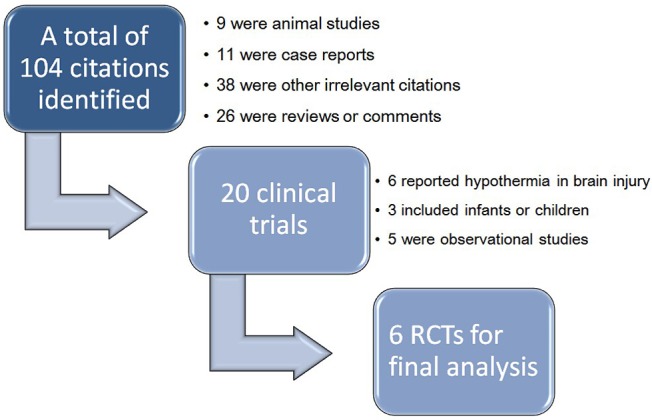
Flowchart of study selection.The initial search identified 402 citations after exclusion of duplicates. 382 of them were excluded by reviewing the titles and abstracts. The remaining 20 articles were clinical studies, in which six studies investigated hypothermia in patients with brain injury, three involved infants or children, and five were observational studies. As a result, a total of 6 randomized controlled trials were included into final analysis.